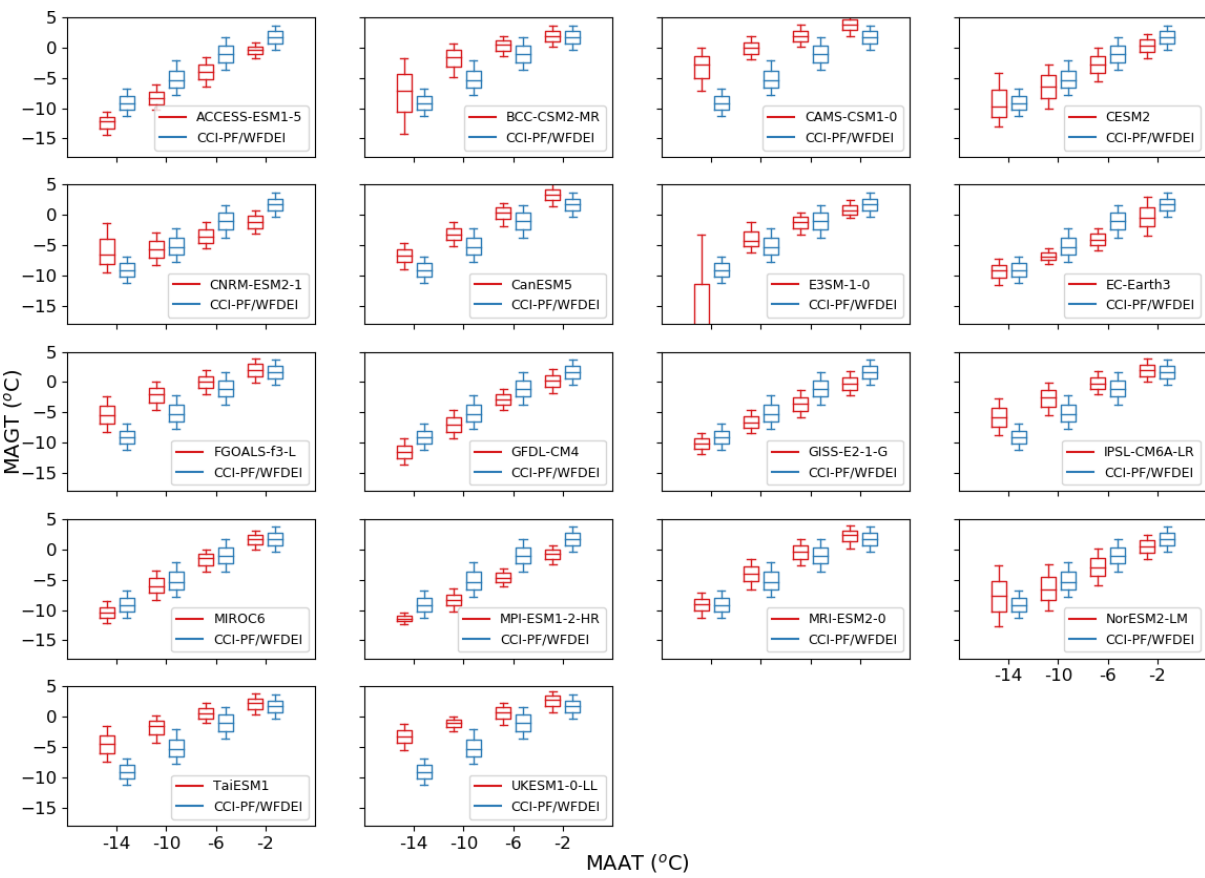
Figure 8. MAGT as a function of local MAAT for the CMIP6 models and the climatological period 1995–2014 (in red). The MAGT observations (in blue) were taken from the CCI-PF data set and the MAAT from the WFDEI data.